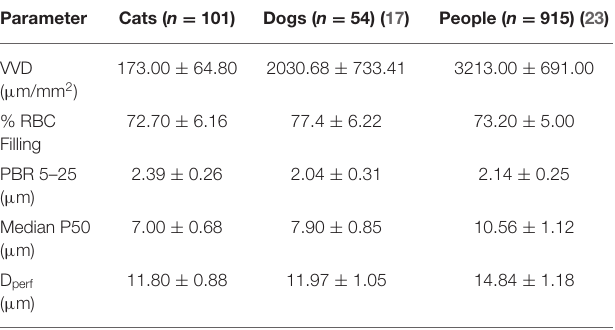
TABLE 5 | Comparison of GlycoCheck ® parameters in cats, dogs and people expressed as mean ± standard deviation.